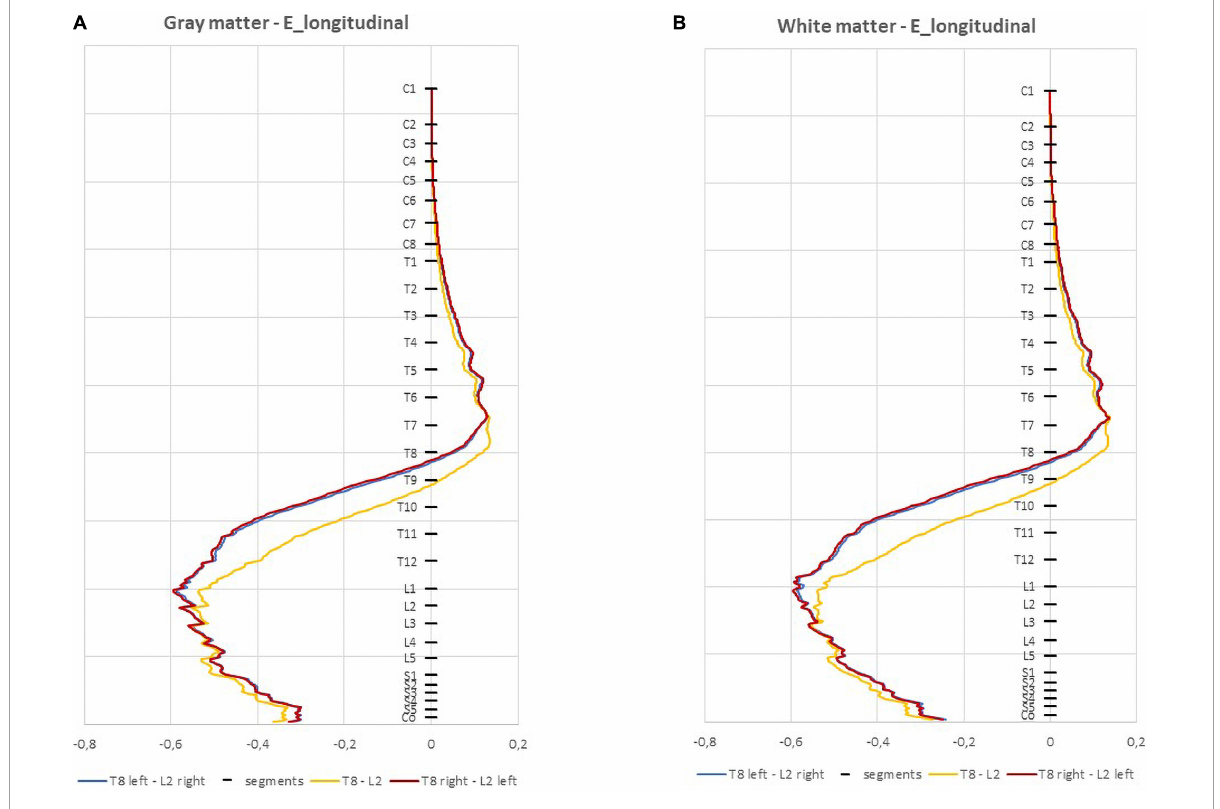
FIGURE4 Average electric field (E-field) longitudinal component (V/m) in 1 mm thick transverse slices along the z direction in the three montages: (A) spinal gray matter (spinal-GM); (B) spinal white matter (spinal-WM). Spinal segments positions along the spinal cord (SC) are indicated in the vertical